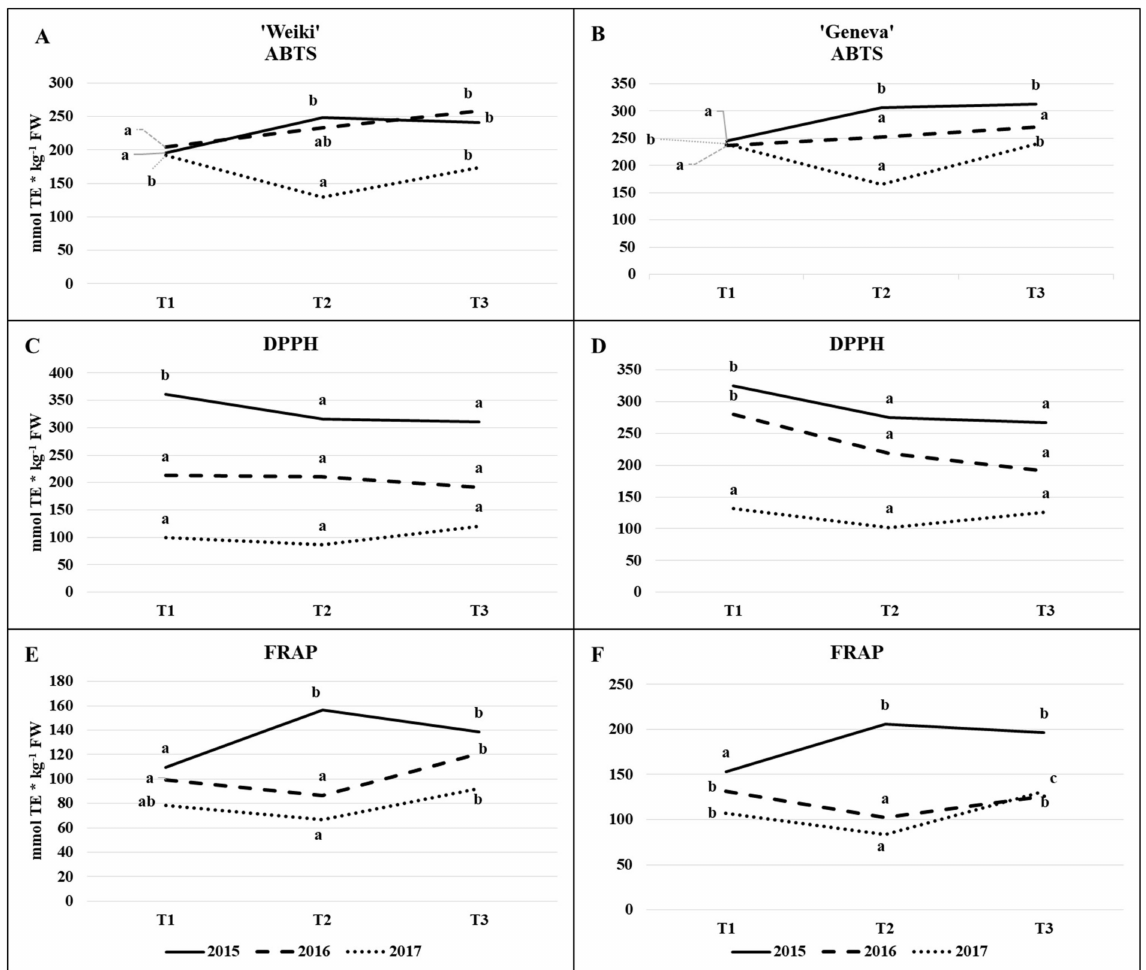
Figure 4. Total antioxidant capacity measured in ABTS (( A ) ‘Weiki’, ( B ) ‘Geneva’), DPPH (( C ) ‘Weiki’, ( D ) ‘Geneva’) and FRAP (( E ) ‘Weiki’, ( F ) ‘Geneva’) tests (mmol TE kg − 1 FW; TE—trolox equivalents) depending on the time of sampling in different growing seasons (2015, 2016 and 2017) in A. arguta leaves. Presented data are means for three soil N levels and three replications. The subsequent years and cultivars were analysed separately; T1—(28.05.15/2.06.16/8.06.17) the stage of fully developed leaves, T2—(16.07.15/14.07.16/18.07.17) the peak of the most intensive fruit growth, T3— (27.08.15/25.08.16/30.08.17) the beginning of fruit physiological maturity. ABTS: 2,2 (cid:48) -azino-bis(3-ethylbenzothiazoline-6- sulphonic acid); DPPH: 2,2-diphenyl-1-picrylhydrazyl; FRAP: ferric reducing antioxidant